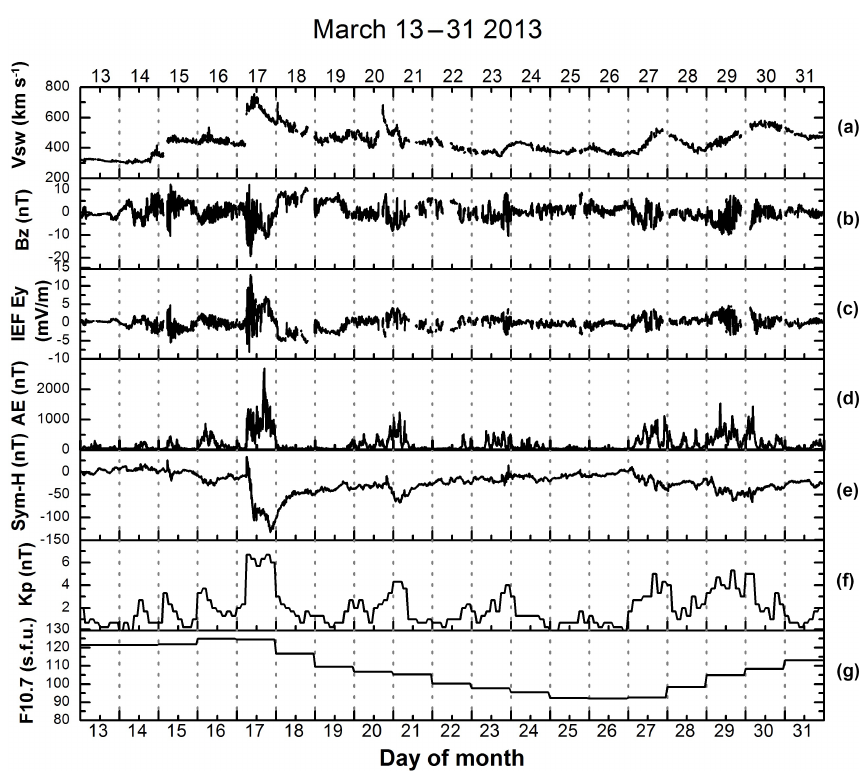
period 13–31 March 2013. Table 1. Locations of four GPS stations and two magnetometers used in this work. Site Geographic Geographic Dip angle Local time latitude longitude Arequipa (Areq) 16.46 ◦ S 71.49 ◦ W 8.94 ◦ S LT = UT − 5 São Luís (Salu) 2.60 ◦ S 44.21 ◦ W 8.73 ◦ S LT = UT − 3 Bogota (Bogt) 4.64 ◦ N 74.08 ◦ W 37.70 ◦ N LT = UT − 5 São Paulo (Poli) 23.20 ◦ S 45.86 ◦ W 37.15 ◦ S LT = UT − 3 Jicamarca 11.95 ◦ S 76.87 ◦ W 0.06 ◦ N Piura 5.20 ◦ S 80.65 ◦ W 12.52 ◦ N LT = UT −